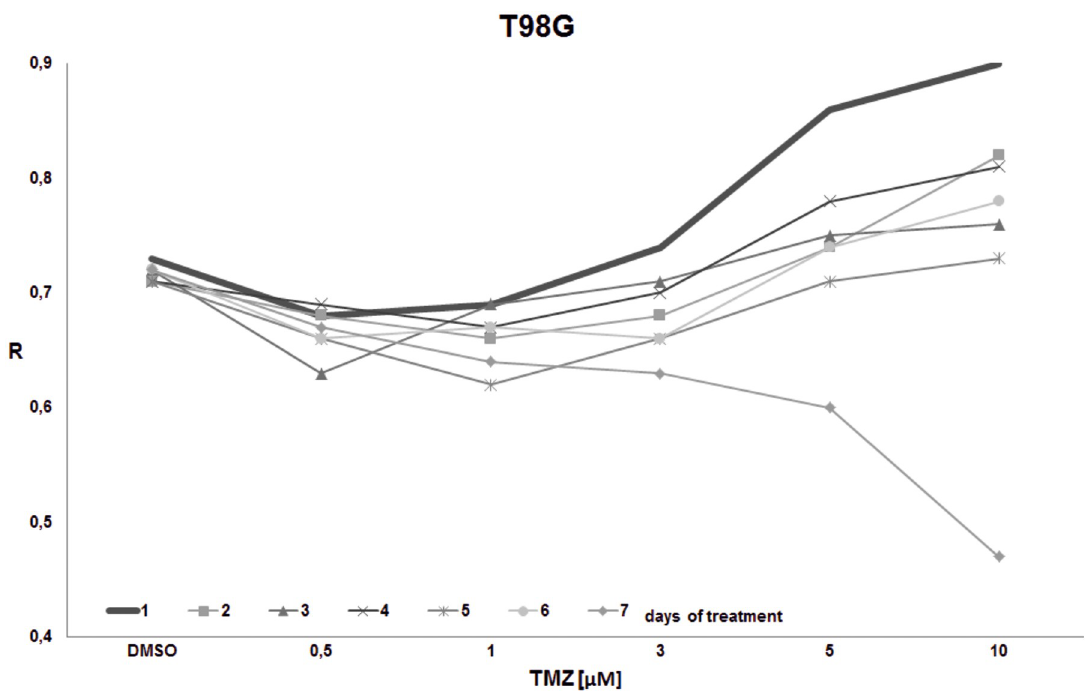
Fig 8. The impact of TMZ exposure period on DNA methylation in T98G cell line. T98G cell culture was treated with the given single dose of TMZ (0.5, 1, 3, 5, 10 μ M) and left for 1–7 days. The global DNA methylation was estimated after 1 st , 2 nd , 3 rd , 4 th , 5 th , and 7 th day of incubation. The highest methylation (R) is seen on day 1 in all concentrations. In concentrations over 3 μ M we observe increasing DNA methylation. On day 7 a hypomethylating trend is observed potentiated by increasing concentration.